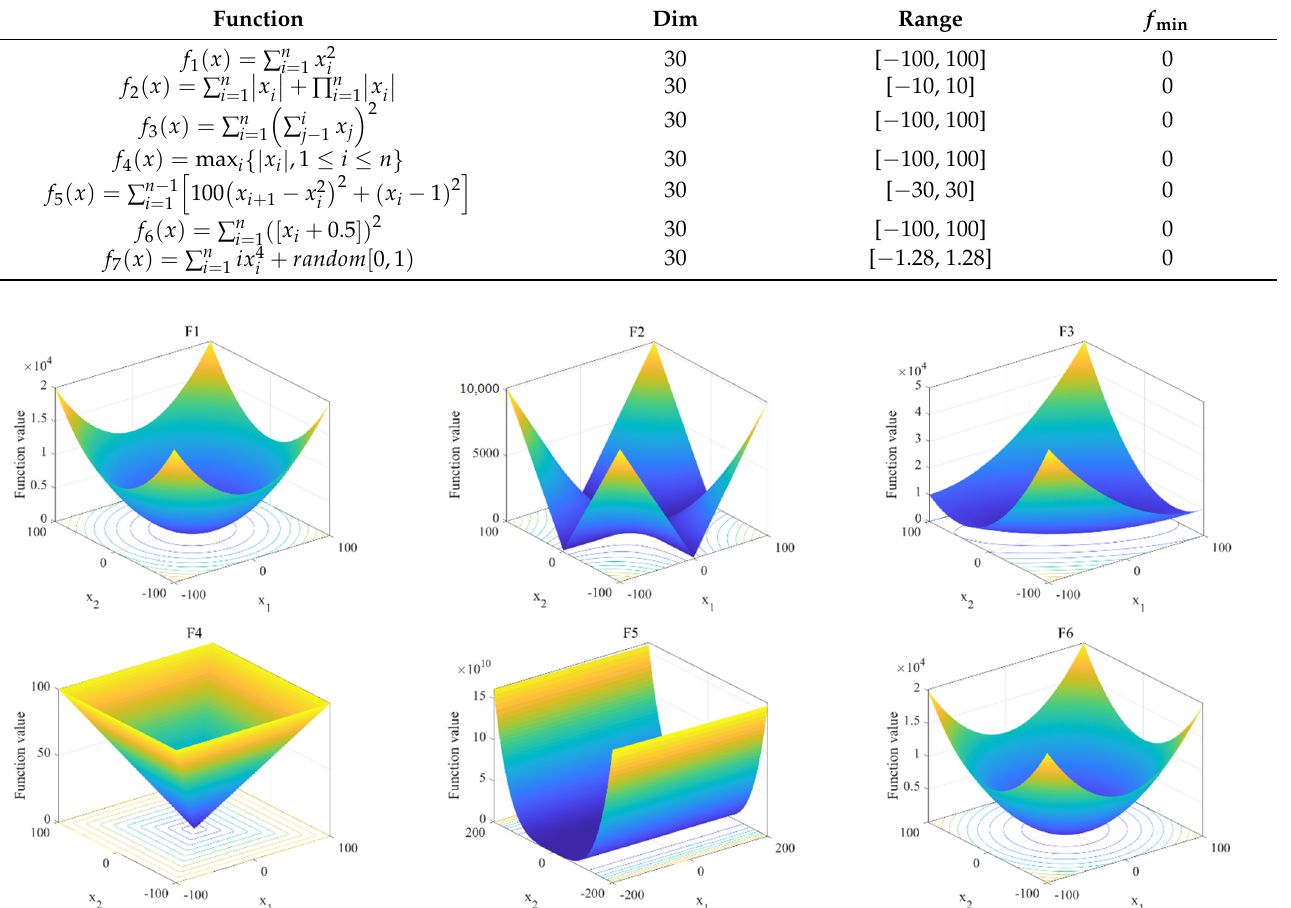
Table 1. Unimodal benchmark functions.